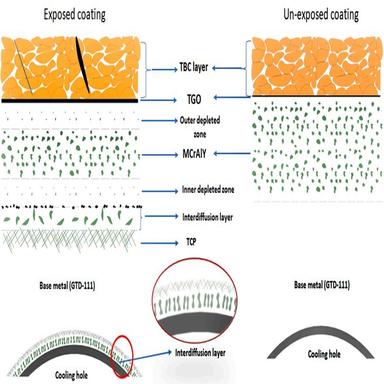
The schematic of inner and outer coating after long term exposure.